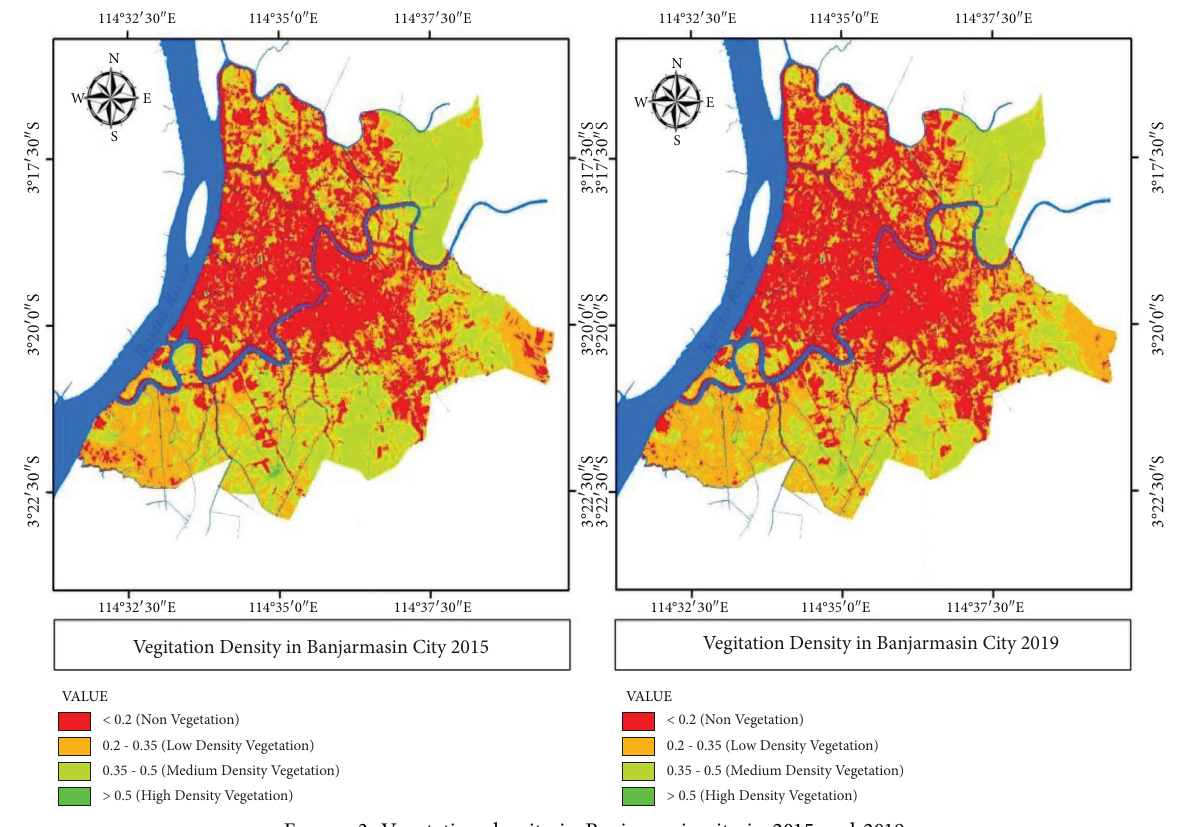
Figure 3: Vegetation density in Banjarmasin city in 2015 and 2019. Table 2: Te area of vegetation density in Banjarmasin City in 2015 and